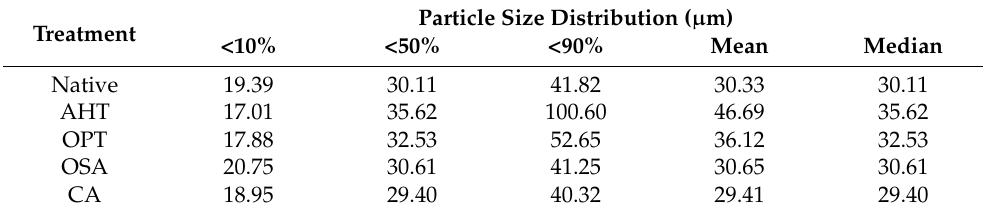
Table 2. Particle size distribution of native and various modified sago starches.